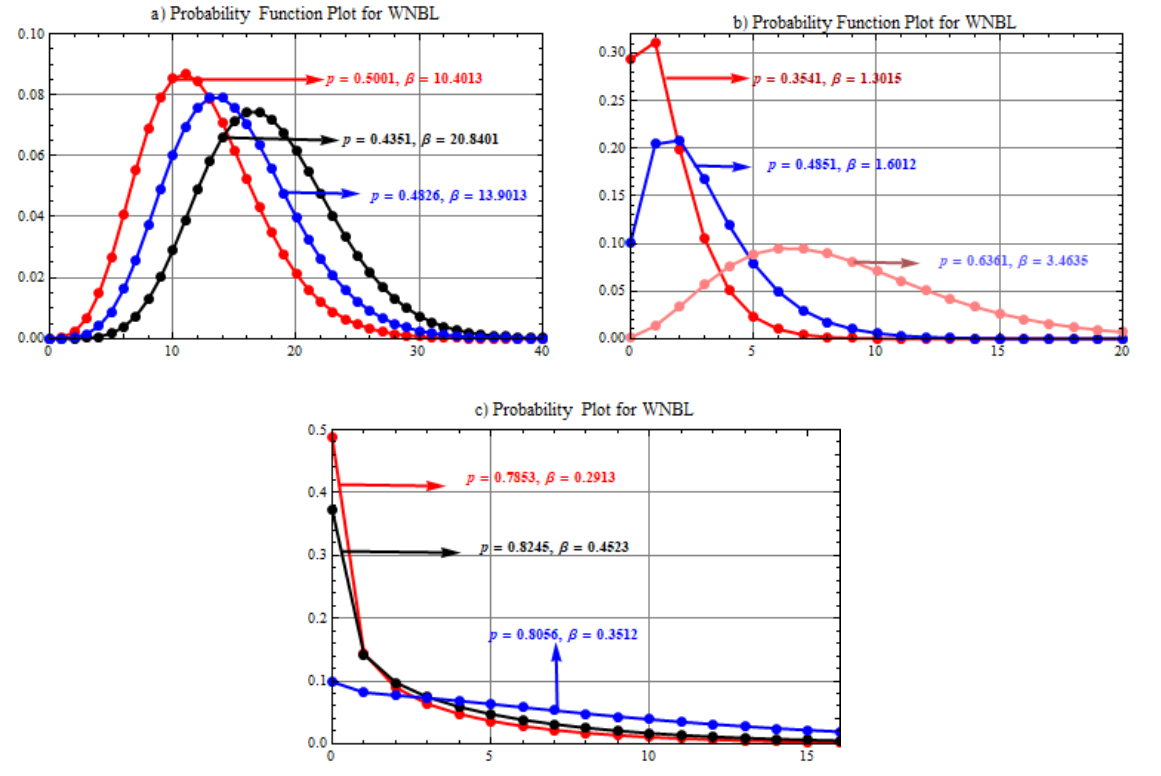
Figure 1 - Probability Graphs for the Indicated Values of p and β of